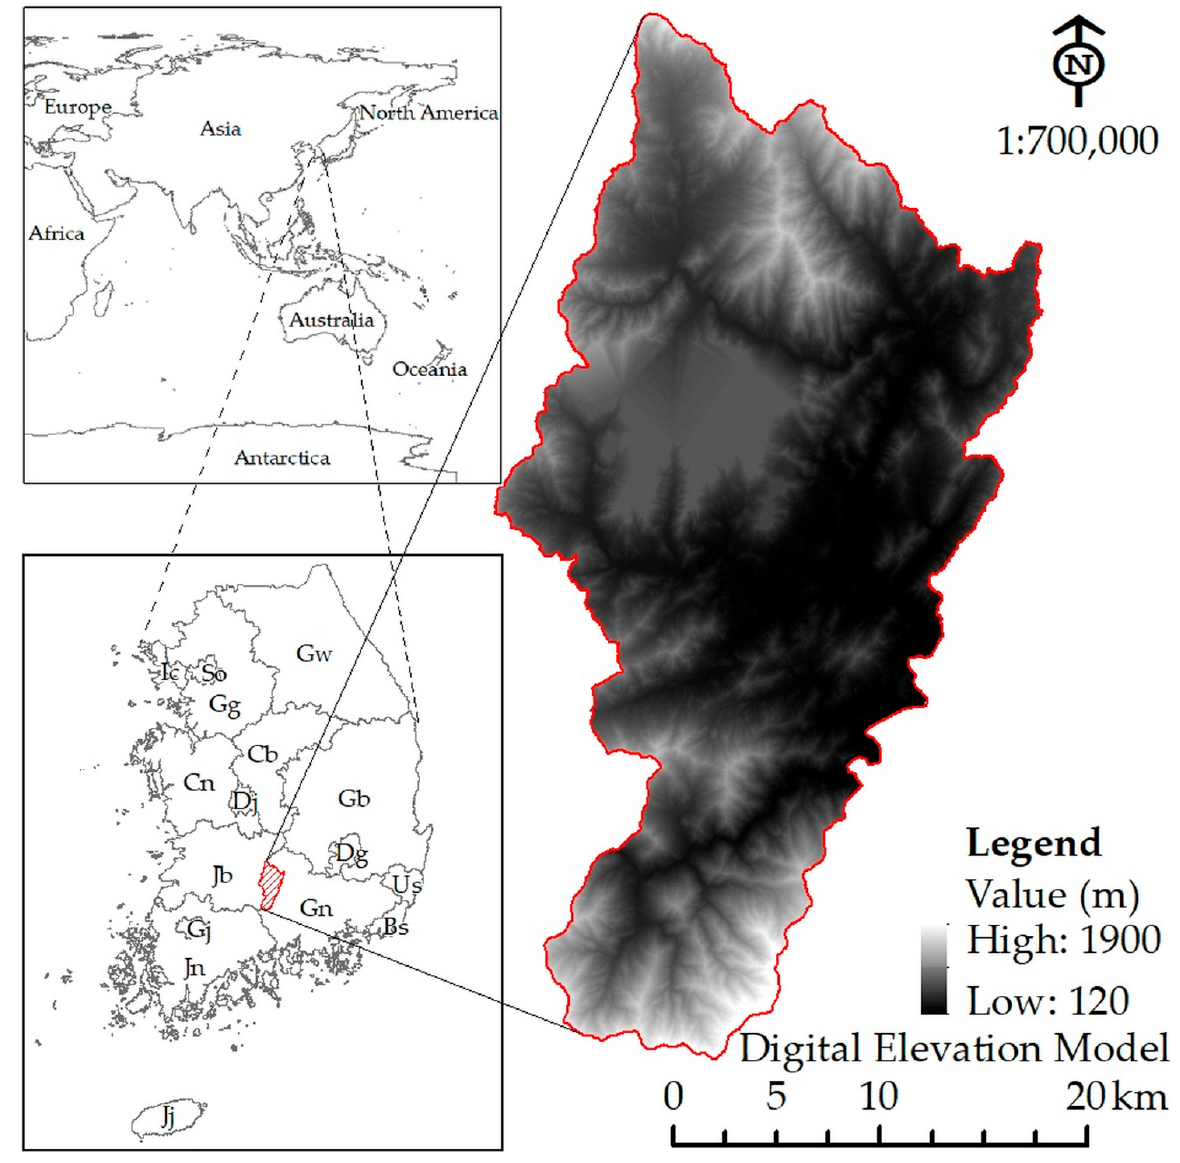
Figure 1. The location of Hamyang-gun of Gyeongsangnam-do in Korea. Note: So = Seoul-si, Ic = Incheon-si, Gw = Gangwon-do, Gg = Gyeonggi-do, Cb = Chungcheongbuk-do, Cn = Chungcheongnam-do, Dj = Daejeon-si, Jb = Jeollabuk-do, Jn = Jeollanam-do, Gj = Gwangju-si, Gb = Gyeongsangbuk-do, Dg = Daegu-si, Us = Ulsan-si, Gn = Gyeongsangnam-do, Bs = Busan-si, and Jj = Jeju-si.